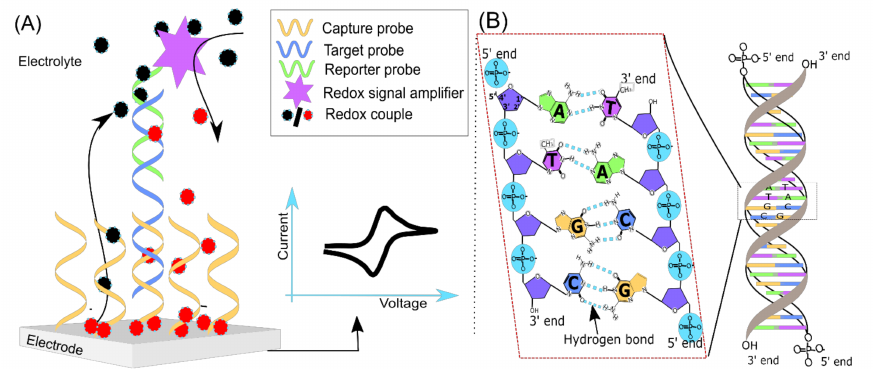
Figure 1. Nucleic acids electrochemical biosensor general principles. ( A ) A sandwich type genosensor model: A capture probe is employed to capture the target (DNA / RNA) from the solution phase to the electrode surface. The electrode bound target DNA is quantified indirectly by binding the reporter probes conjugated with a redox signal amplifier. The redox signal amplifier could be an enzyme or